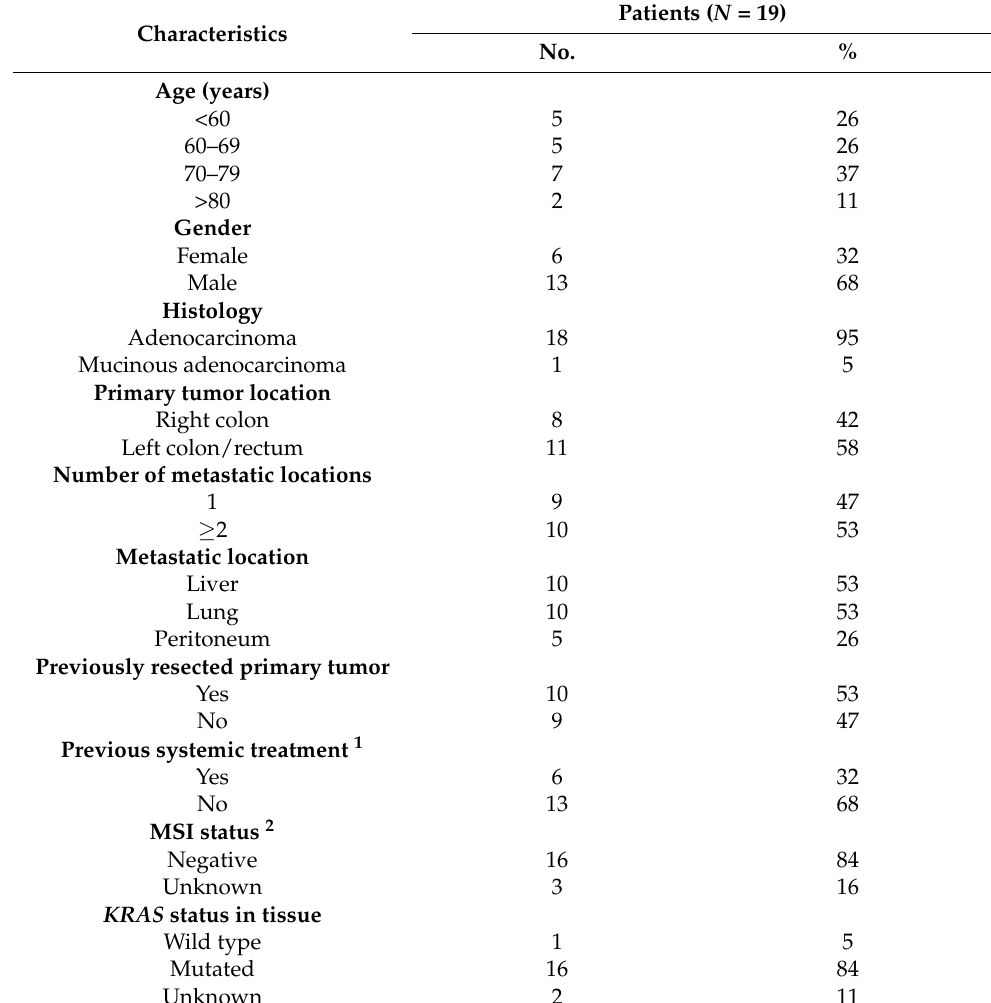
Table 1. Clinical characteristics of mCRC patients included in the